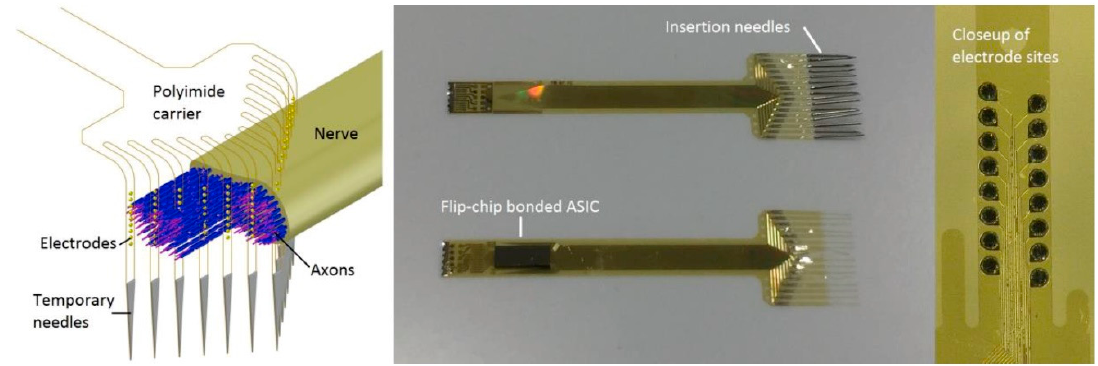
Figure 1. Neural probes for rat sciatic nerves. Left: concept, right: fabricated